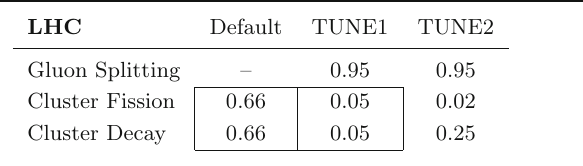
Table 2 Results of the parameter values for strangeness production at the different stages of the event generation (LHC). In both default Herwig and TUNE1, cluster fission and decay have the same parameter, while in TUNE2 they are allowed to be different. In default